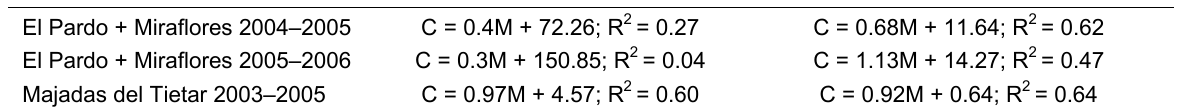
Values Using the Results of the Regression Analyses Between Measured (M) and Calculated (C) g s New Parameterization of the g Model With or Without f s SMD Literature Parameterization Literature Parameterization + f